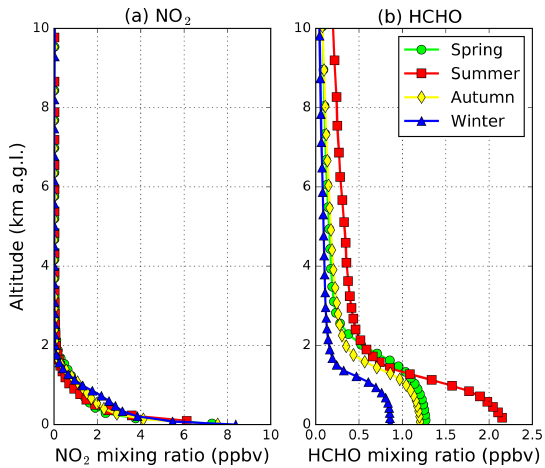
Figure 7. Vertical distribution of (a) NO 2 and (b) HCHO for differ- ent seasons. Shaded areas represent 1 σ standard deviation of varia-